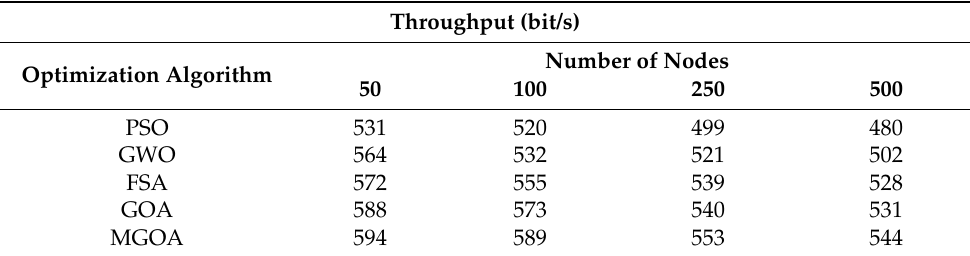
Table 3. Performance analysis of MGOA-WAVLCN in terms of